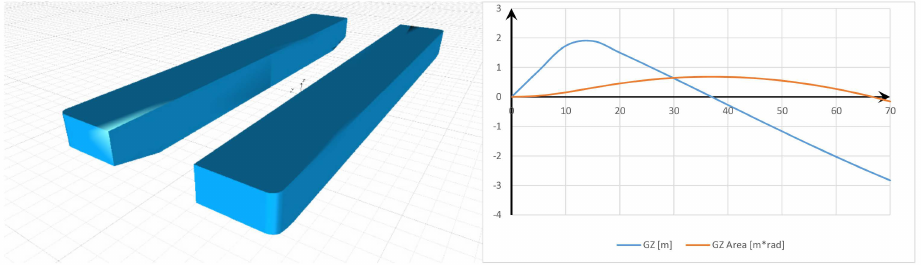
Figure 6. Model 3. GZ and Work (GZ Area) curve for initial condition. Table 2. Parameters of dredgers’ models.